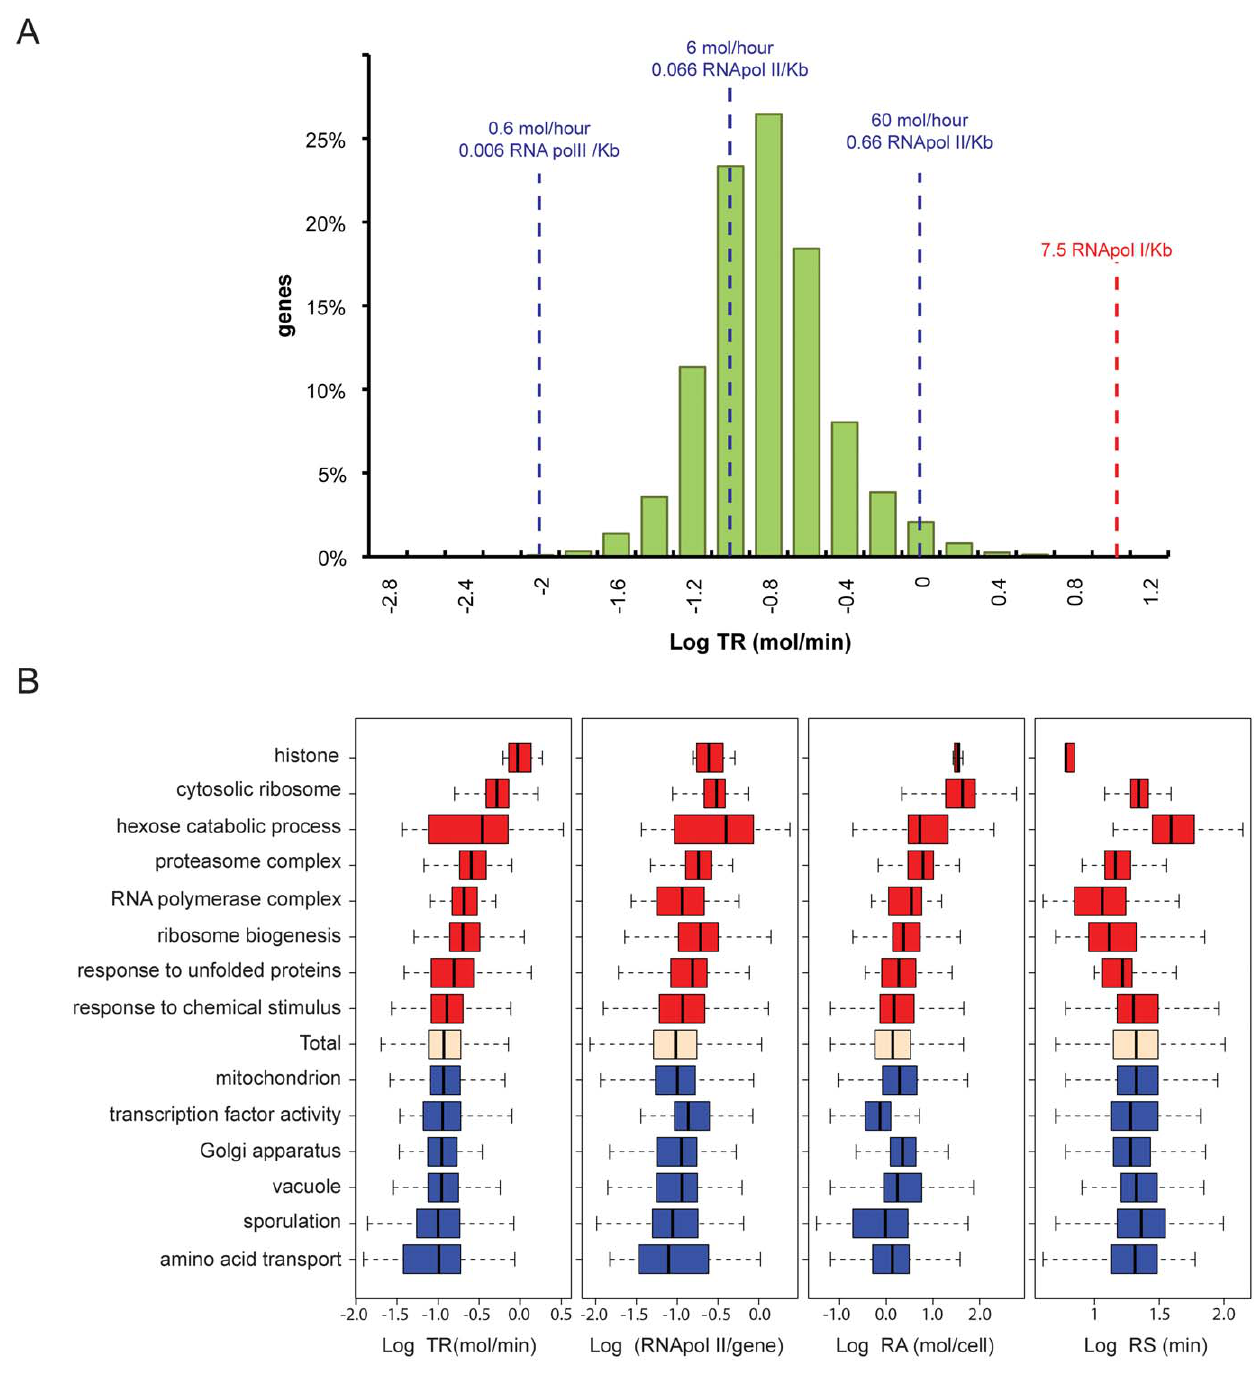
Figure 3. Nascent TR data set. A) Histogram of the yeast nascent productive TR data set in real units (molecules per hour, mol/hour) and RNA pol II densities (RNA pol II molecules per kb, mol/kb) for all the genes. The RNA pol I density [32] is shown as a reference with a dashed red line. The natural values of RNA pol II density and TR corresponding to 2 2, 2 1 and 0 units in log scale are shown as dashed blue lines. B) Comparison of nascent TR, RNA pol II molecules per gene, RNA amount (RA, using RNA-Seq data corrected with GATC-PCR, see [Methods]) and mRNA stability from ref. [17] for the different selected groups of genes (GO categories). The box plots represent the median and quartiles of the data. The whiskers show the maximum and minimum of the data set (excluding the outliers which lie beyond 1.5 times the inter quartile range).